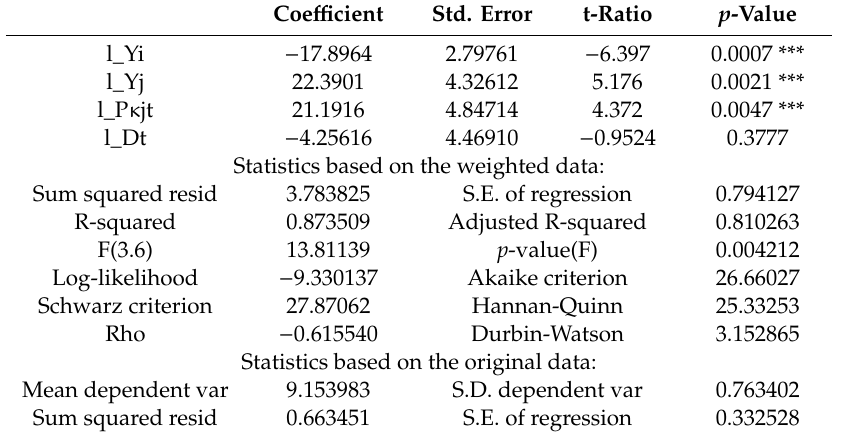
Table 7. FGLS estimation of Croatian tourist consumption in Hungary—model 2. Model 4: FGLS, using observations 2009–2018 (T = 10); dependent variable: l_TXij; variable used as weight: l_Dt.